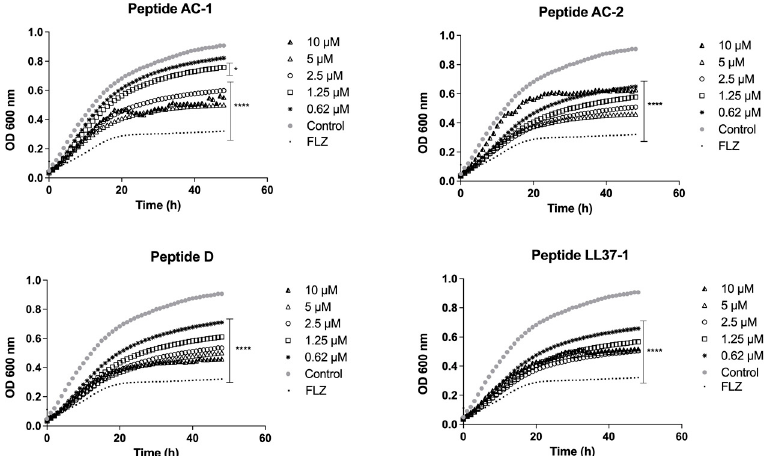
Figure 5. Growth curves of C. parapsilosis ATCC 22019. Four LL-37 analogue peptides (AC-1, AC-2, D, and LL37-1) were tested at different concentrations (10, 5, 2.5, 1.25, and 0.62 µM). C. parapsilosis ATCC 22019 cells without exposure to antimicrobial peptides were used as a control. Fluconazole (64 µg/mL) was used as antifungal control. Data represent three independent experiments. Statistical significance * p < 0.05; **** p < 0.0001 compared to control.